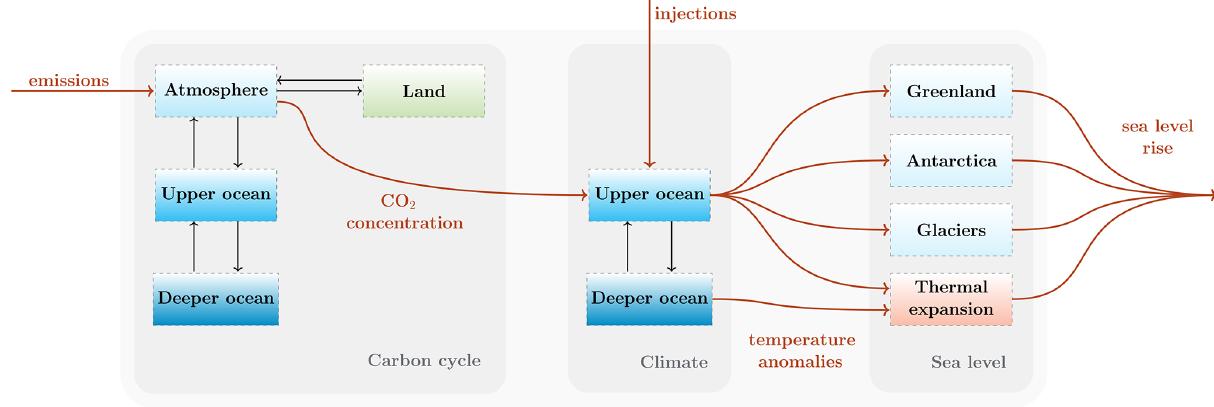
Figure 1. Conceptual diagram of SURFER. The state variables are indicated by the boxes, interactions and sources are depicted by black and dark orange arrows respectively.